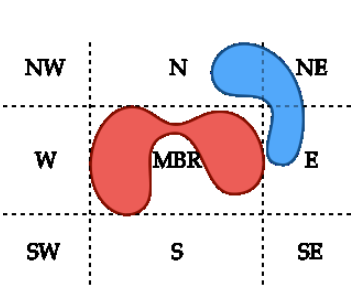
Figure 8: The direction relation matrix [30]. Using the object in the center of the figure, the minimum bounding rectangle (M) is constructed. The direction relation matrix then uses these tiles and assigns either a Boolean value or a proportion to represent the